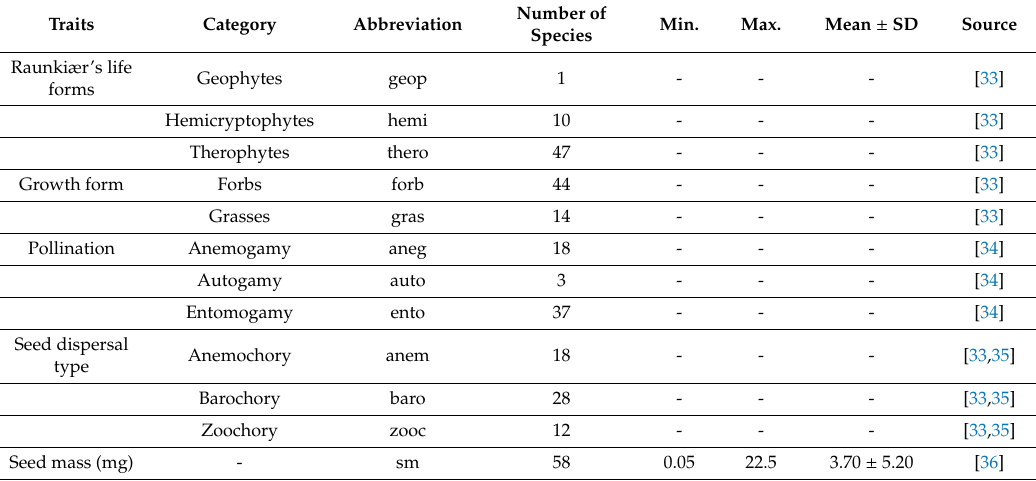
Table 1. List of qualitative and quantitative traits used for the 58 species analyzed.